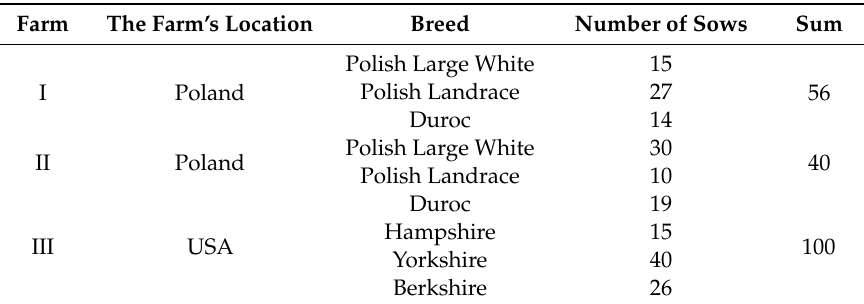
Table 1. The number of sows studied per